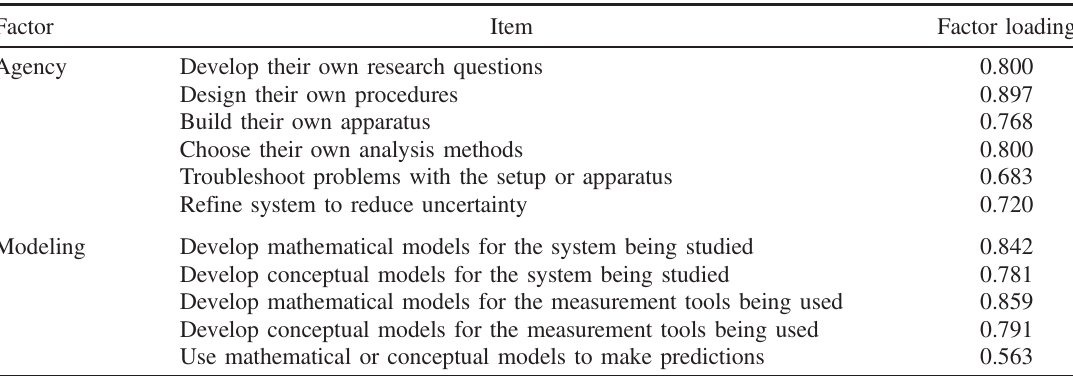
TABLE II. Factor loadings for the two-factor confirmatory factor analysis to aggregate responses to the frequency items related to student agency and